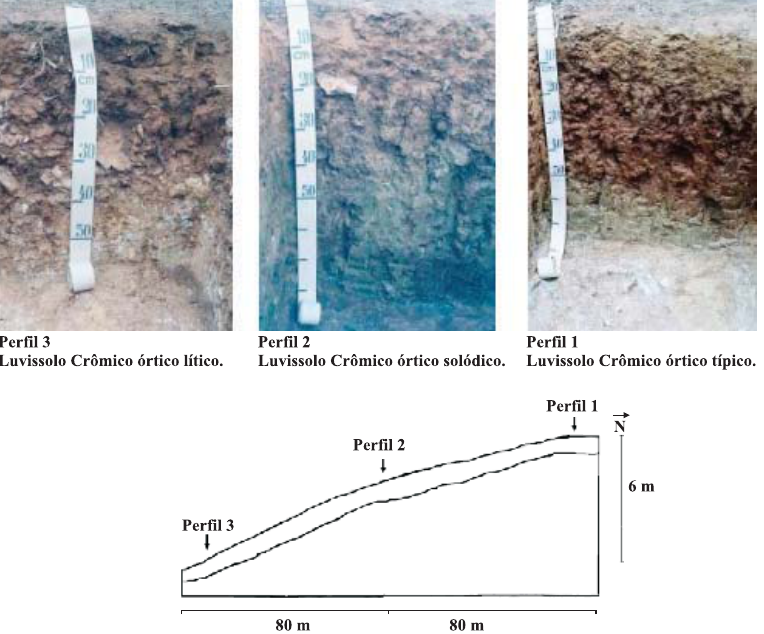
Figura 1. Representação esquemática da localização dos perfis ao longo da sequência e fotografias dos perfis de solo da Topossequência I.